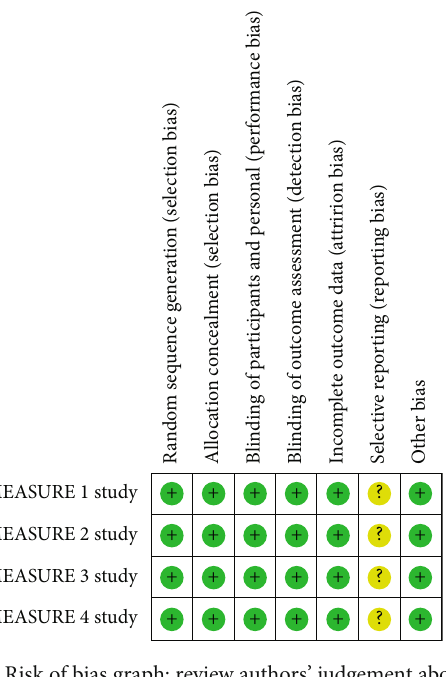
ClinicalTrials.gov